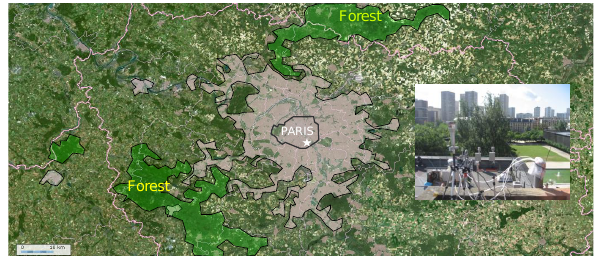
Figure 2. Map of Paris and Ile de France region. The star locates the position of the LHVP 3 Fig. 2. Map of Paris and Ile de France region. The star locates the laboratory. The picture shows the terrace roof of LHVP. 4 position of the LHVP laboratory. The picture shows the terrace roof of